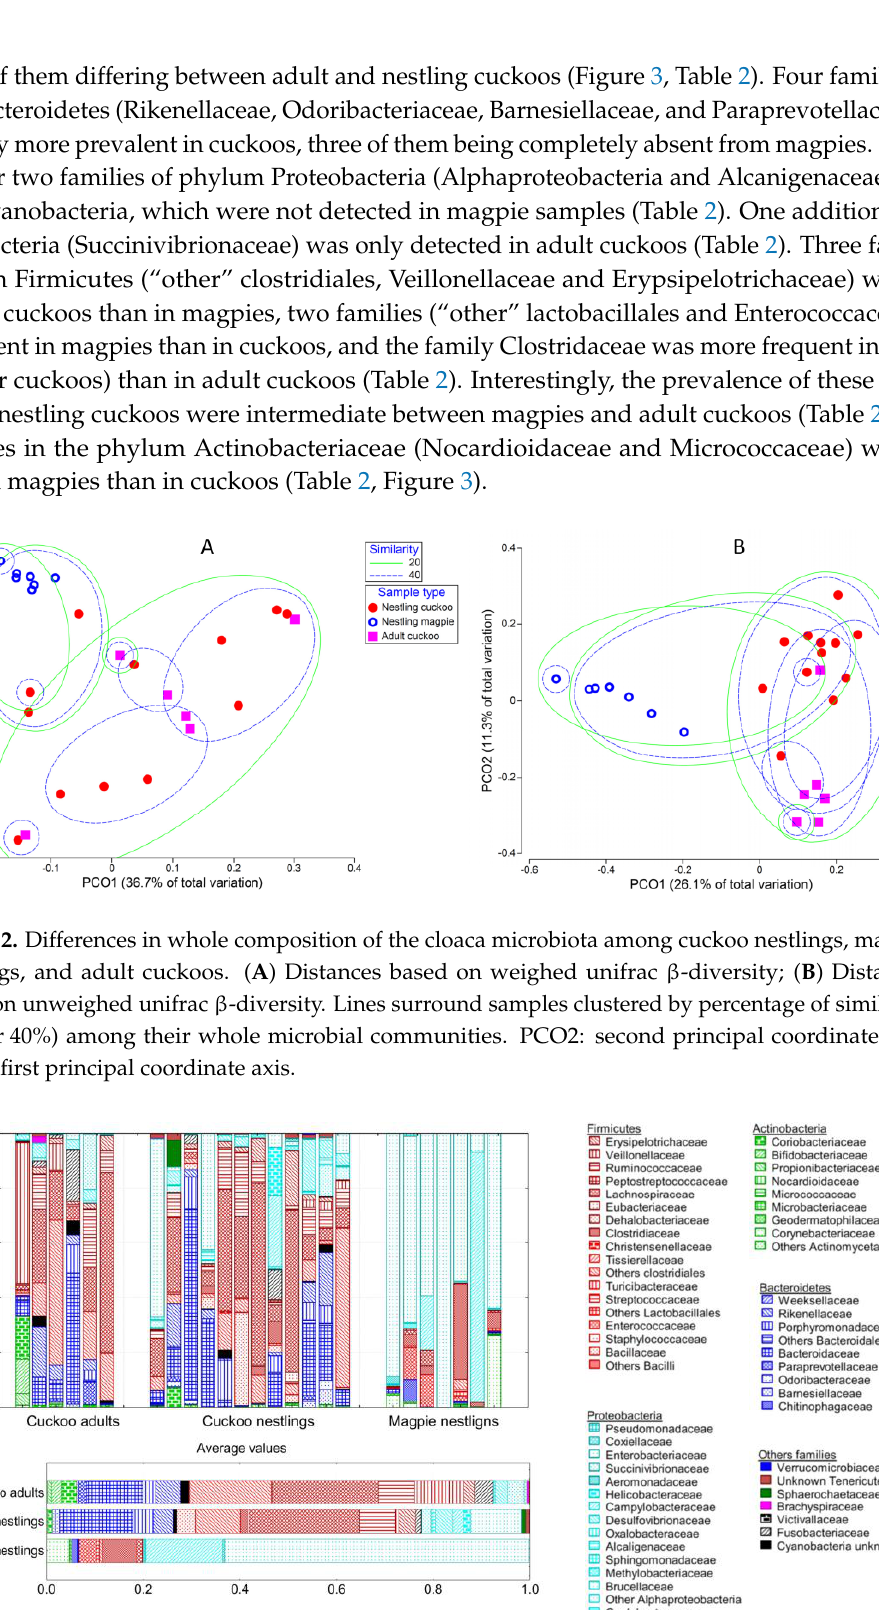
Figure 3. Relative abundance of bacterial families belonging to different phyla detected in the gut microbiome of cuckoo adults, cuckoo nestlings, and magpie nestlings. Individual and average information are shown.